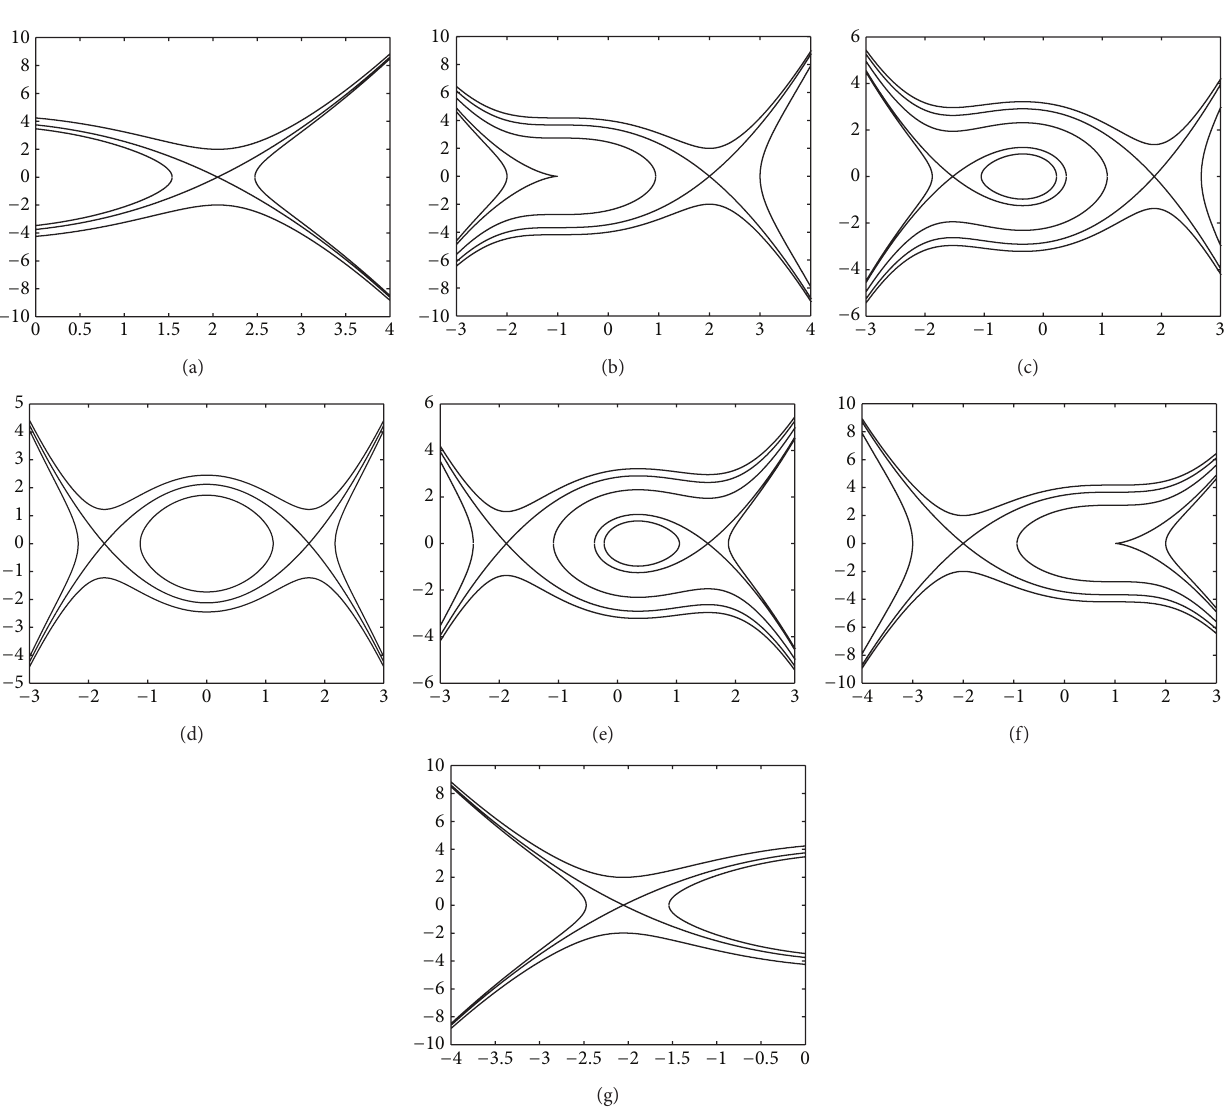
Figure 4: Phase portraits for 𝑡 = (from top-left to bottom-right): − 2.5 (𝑡 < 𝑡 connections between two saddles of associated system, 𝑡 ∗ 0 = 0 ); 1; 2 ( 𝑡 = 𝑡 In our case 𝑡 𝐵 = −2.45, 𝑡 𝐸 = 2.1, 𝑎 ≡ 1, 𝑓(𝑦) = 3𝑦−𝑦 3 , 𝑚(𝑡) = 𝑡, 𝑡